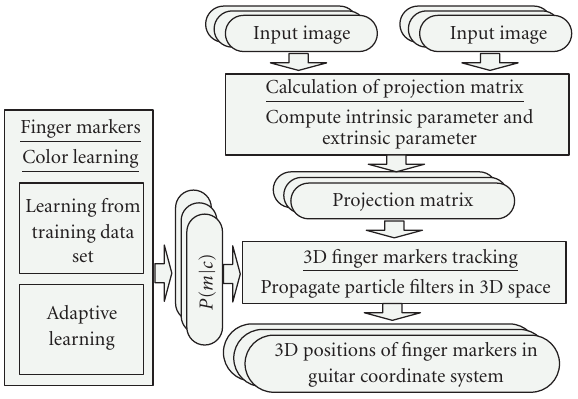
Figure 2: Method overview.